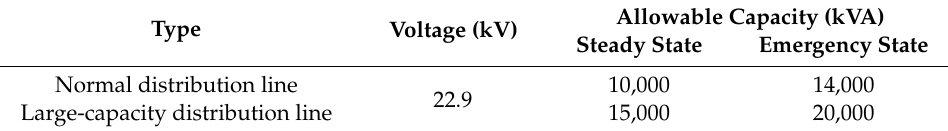
Table 3. The allowable integration capacity for DER into the distribution